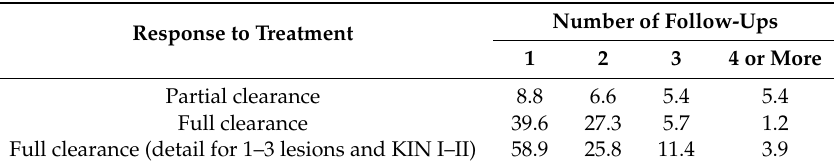
Table 3. Follow-ups and percentages of patients for clearance.